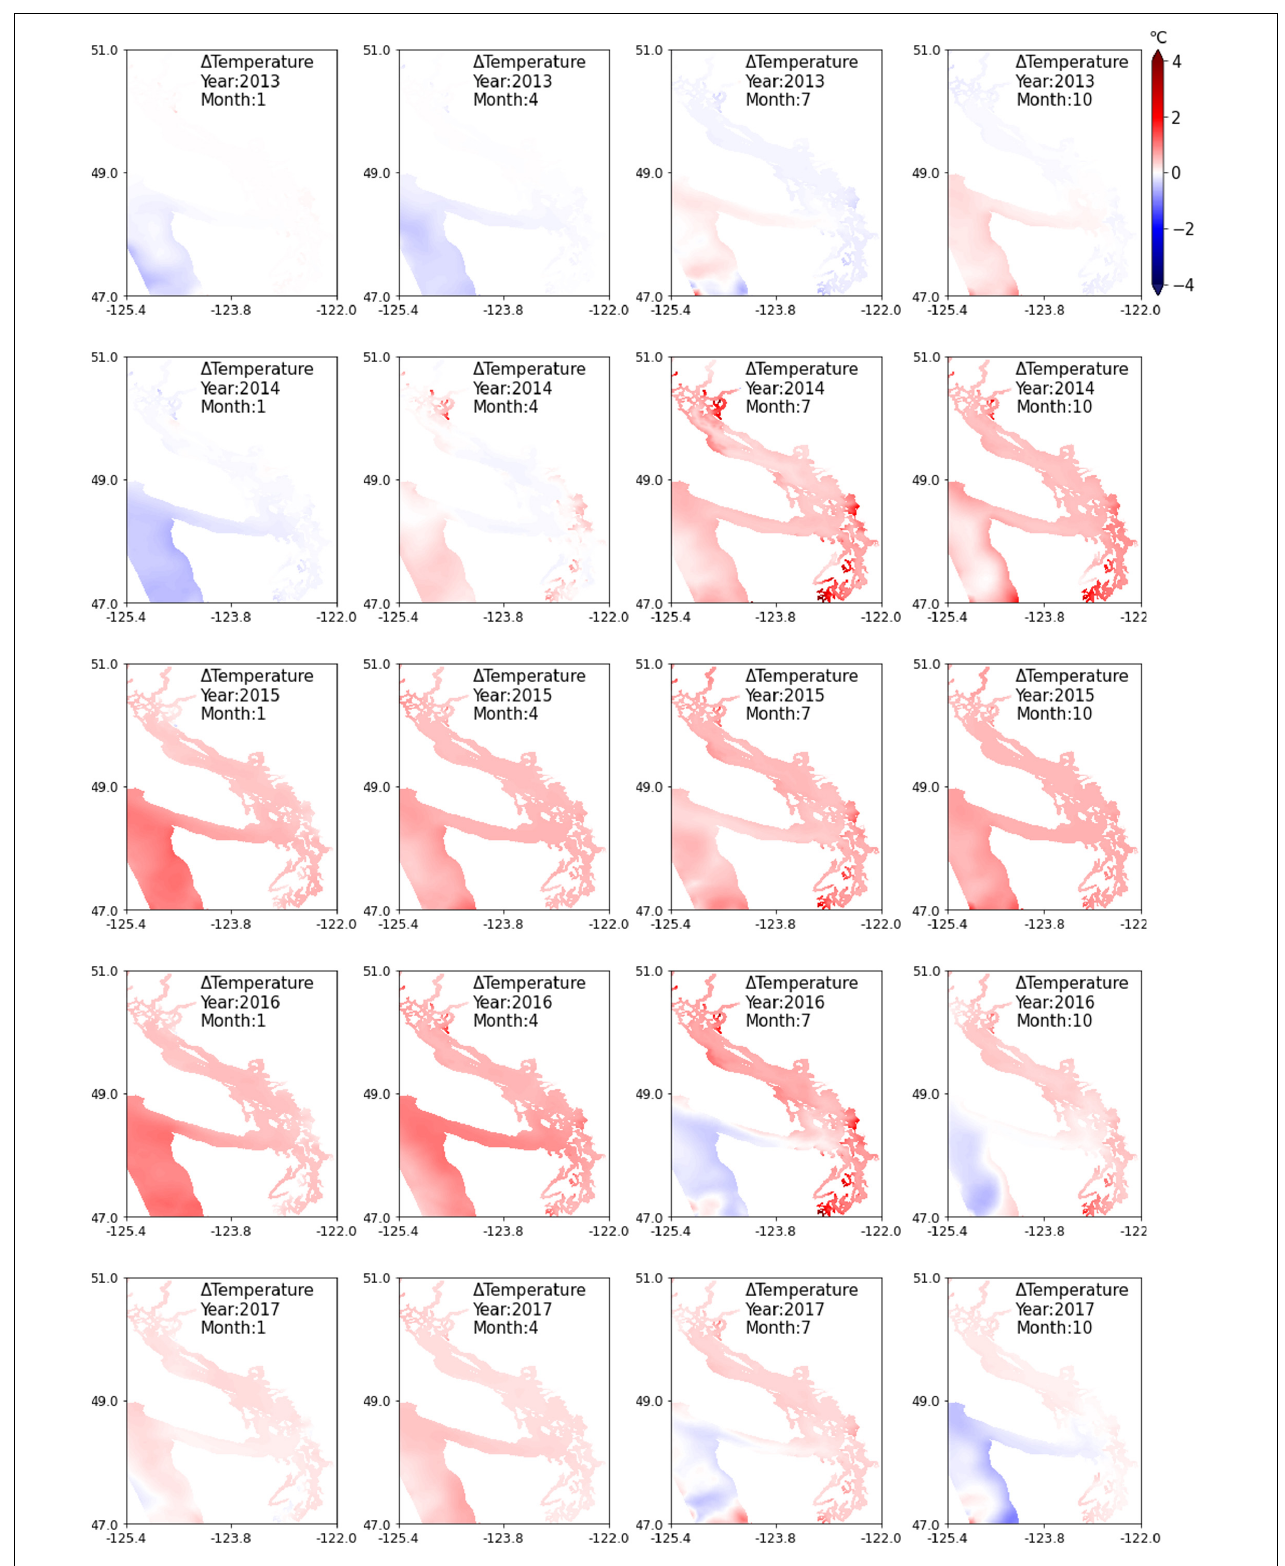
FIGURE 8 | Temperature difference ( (cid:49) T) by season relative to reference conditions (without marine heatwave effects), depth-averaged contours with a focus on Salish Sea region for years 2013 to 2017.